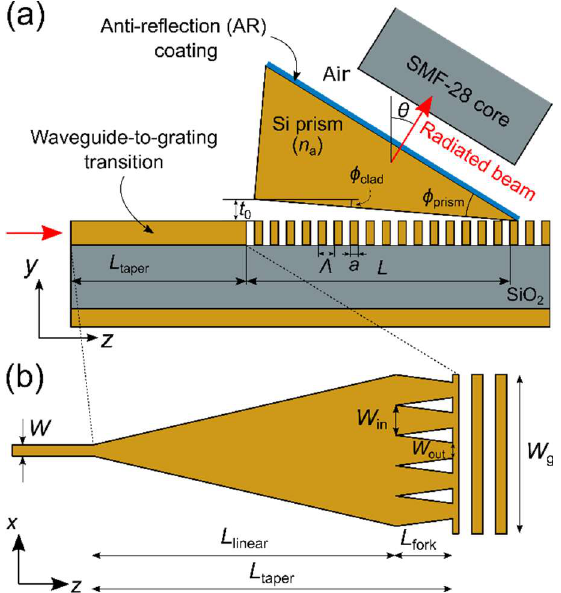
Fig. 1. (a) Schematic of a zero-order fiber-chip coupler (side view). (b) Schematic of the waveguide-to-grating transition (top view) used to adapt the guided mode of the input homogeneous waveguide to the Bloch–Floquet mode supported by the zero- order grating coupler.